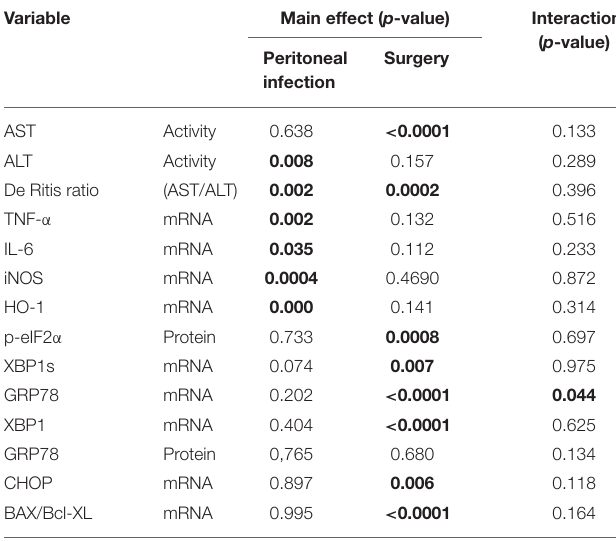
TABLE 1 | Main effects of peritoneal infection and surgical stress on inflammatory markers, unfolded protein response, and interaction of both the conditions determined by two-way